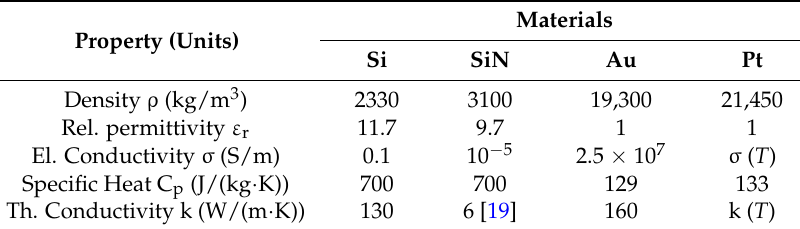
Table 1. Physical properties of the materials involved.